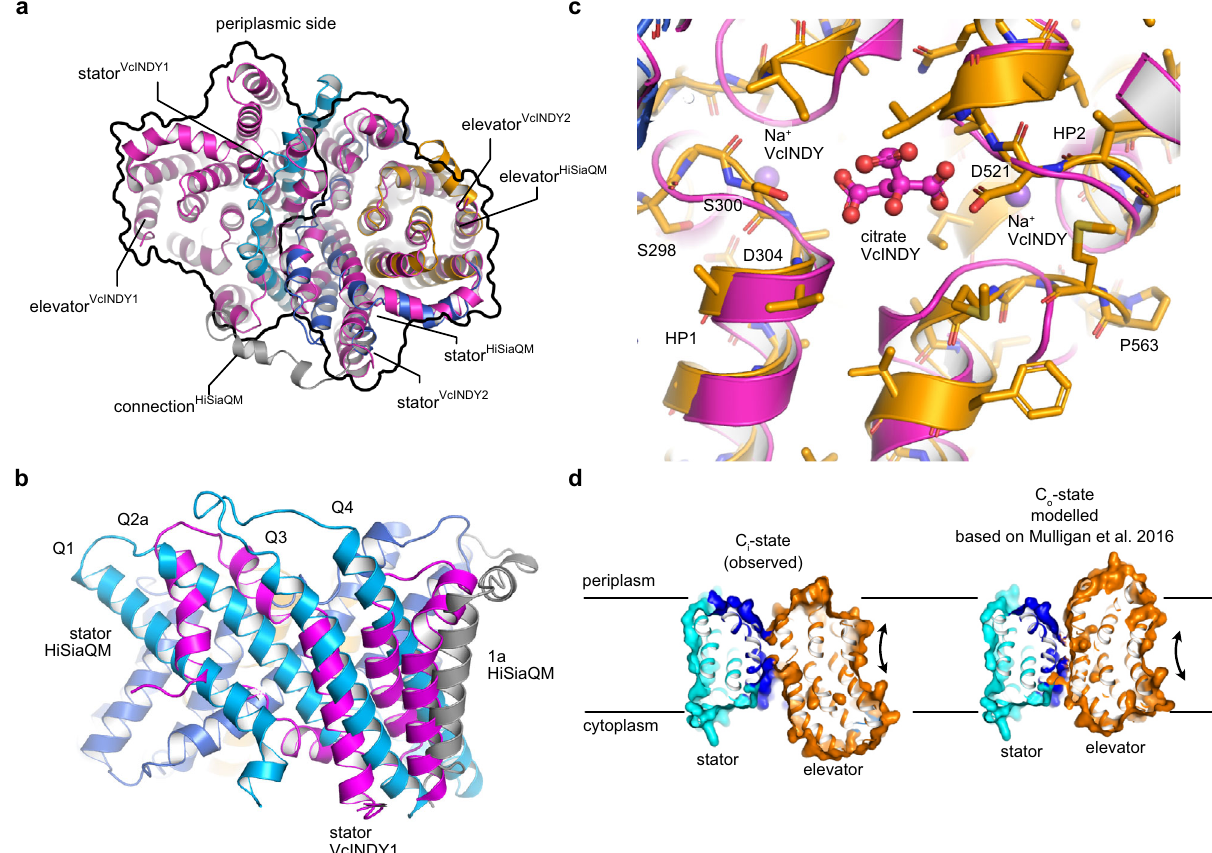
Fig. 2 Comparison of the TRAP transporter HiSiaQM with elevator-type transporters. a Superposition of HiSiaQM (colored coded as in Fig. 1) onto one unit of the dimeric VcINDY transporter in its C i state (magenta, 5UL9 39 ). The outline of the two VcINDY monomers is drawn as a black line. Note that the Q-domain of HiSiaQM clearly crosses the “ border ” between the two VcINDY monomers. b Close-up view of the Q1 – Q4 helices from ( a ). The magenta helices are part of the VcINDY stator domain. c The substrate-binding site of VcINDY aligned to HiSiaQM, showing the two Na + ions and the citrate molecule in the VcINDY structure. d Side view of HiSiaQM in the C i state from Fig. 1c (left) and a model of the outward open C o state (right) that was constructed based on the C o state of VcINDY 31,45 – 47